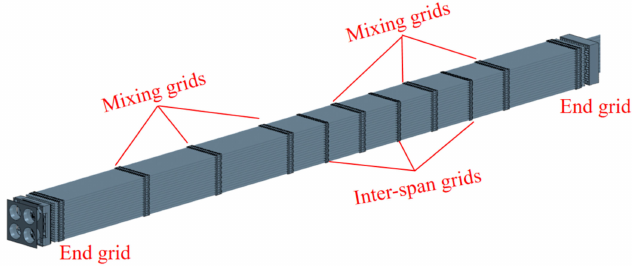
Figure 11. Mesh of the whole fuel